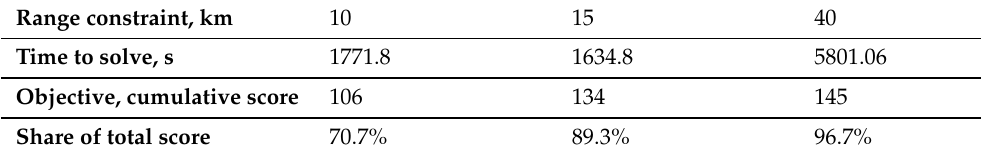
Figure 3. Exact solutions of the small instance. ( a ) Length constraint of 10 km. ( b ) Length constraint of 15 km. ( c ) Length constraint of 20 km. Table 1. Time spent and other statistics from the three different exact